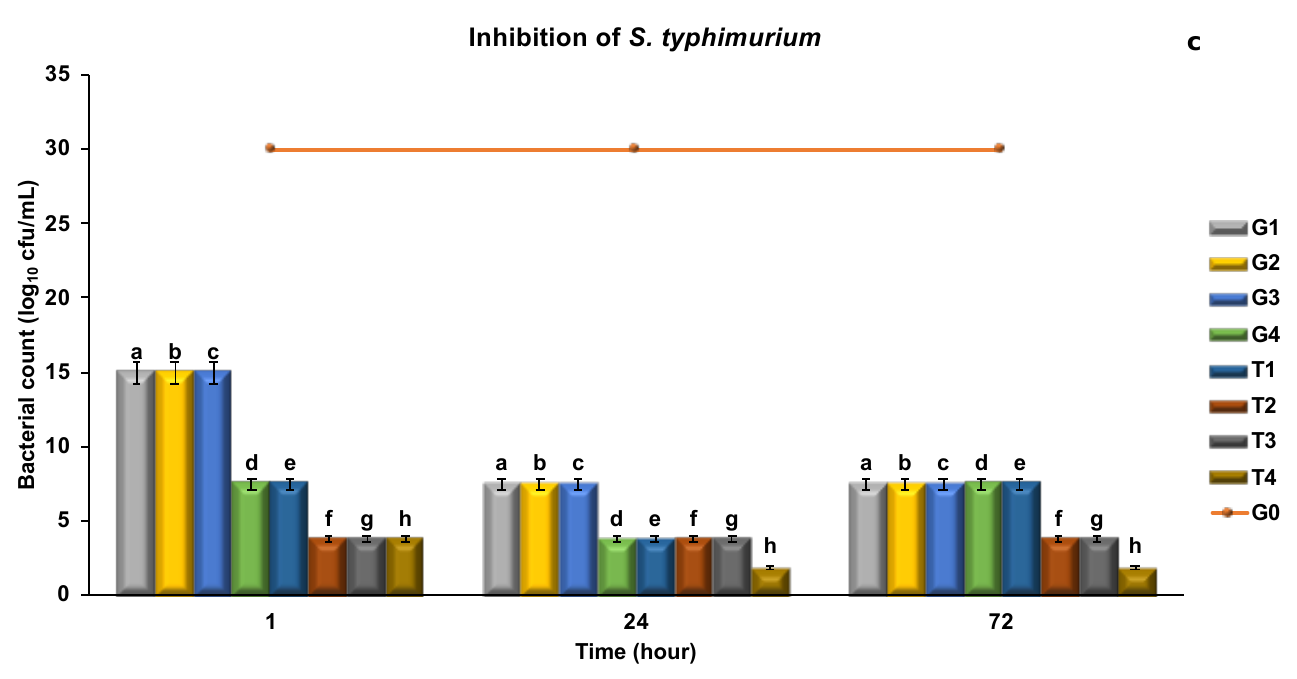
Figure 5. MIC values of meatballs determined at different times. ( a ) Inhibition of E. coli , ( b ) Inhibition of L.monocytogenes , ( c ) Inhibition of S. typhimurium . The results are expressed as mean ± standard error. a–h For each day, columns representing different values are labeled with different letters.